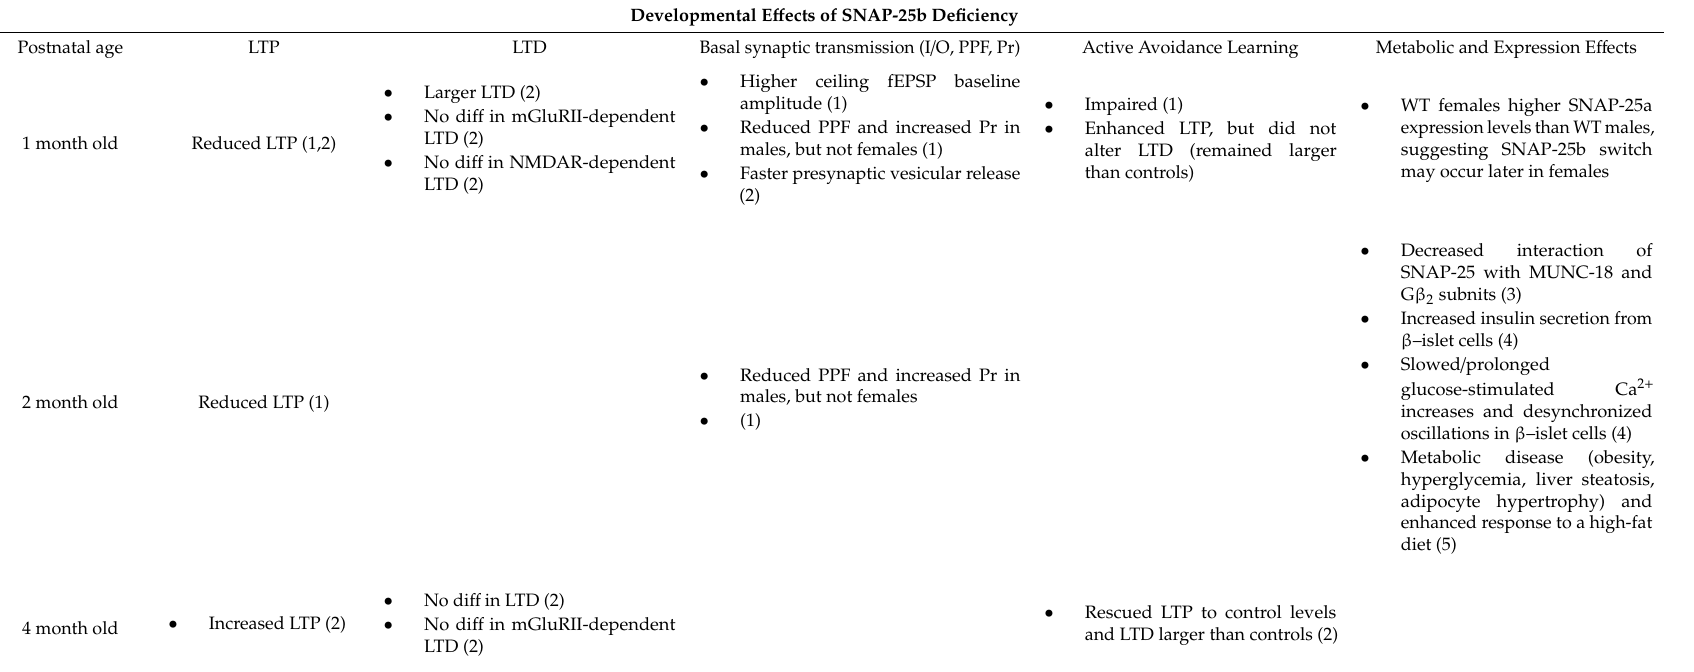
Table 1. Developmental E ff ects of SNAP-25b